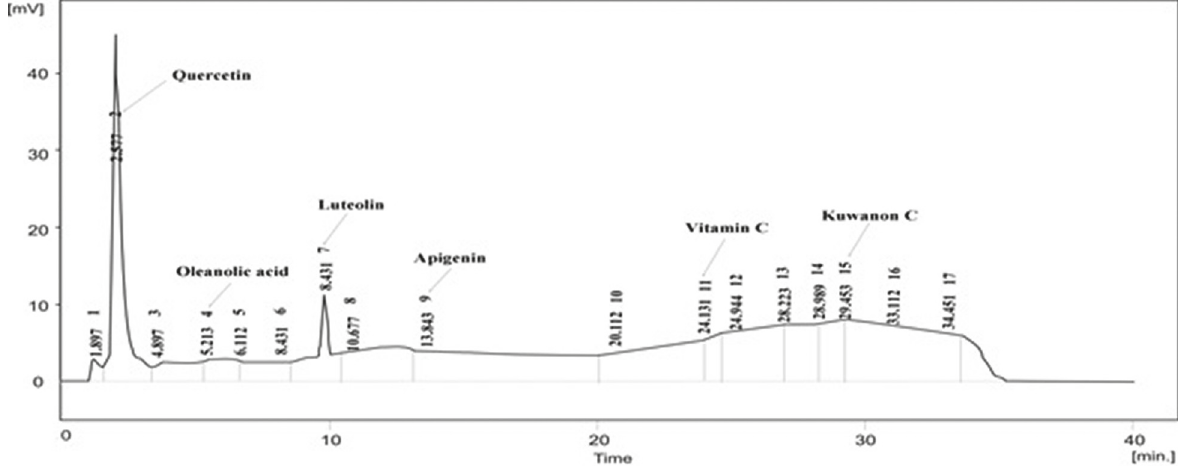
FIGURE 1 - HPLC chromatogram of n -hexane extract of Morus nigra showing presence of qurecetin, oleanolic acid, luteolin, apigenin, vitamin C and kuwanon C at 280 nm